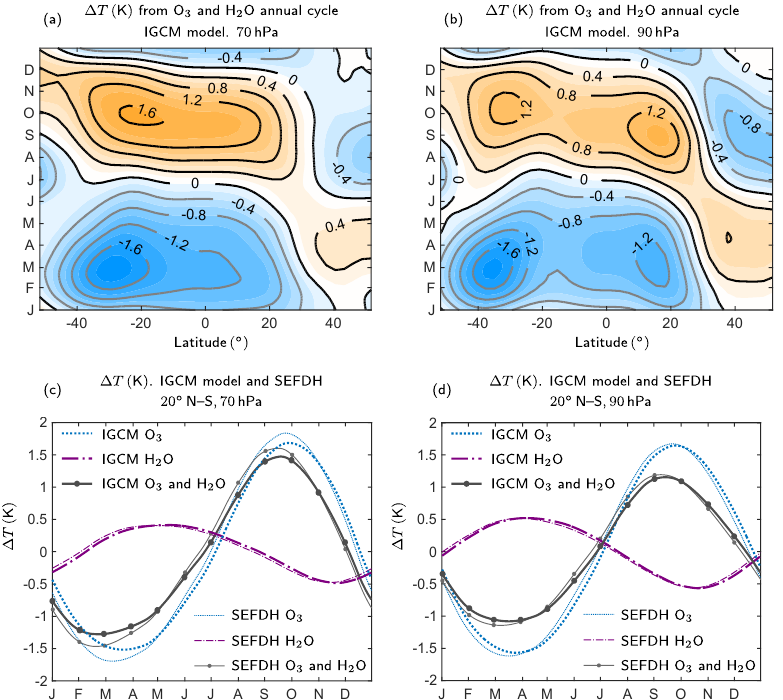
Figure 12. Temperature changes (K) calculated using the idealized dynamical model (IGCM) with annual cycles in both ozone and water vapour shown at (a) 70hPa and at (b) 90hPa. Temperature changes averaged between 20 ◦ N and 20 ◦ S at (c) 70hPa and (d) 90hPa and showing the effects of ozone and water vapour in the dynamical model (thick lines) as well as the corresponding SEFDH temperature changes from Fig. 7a and b (thin